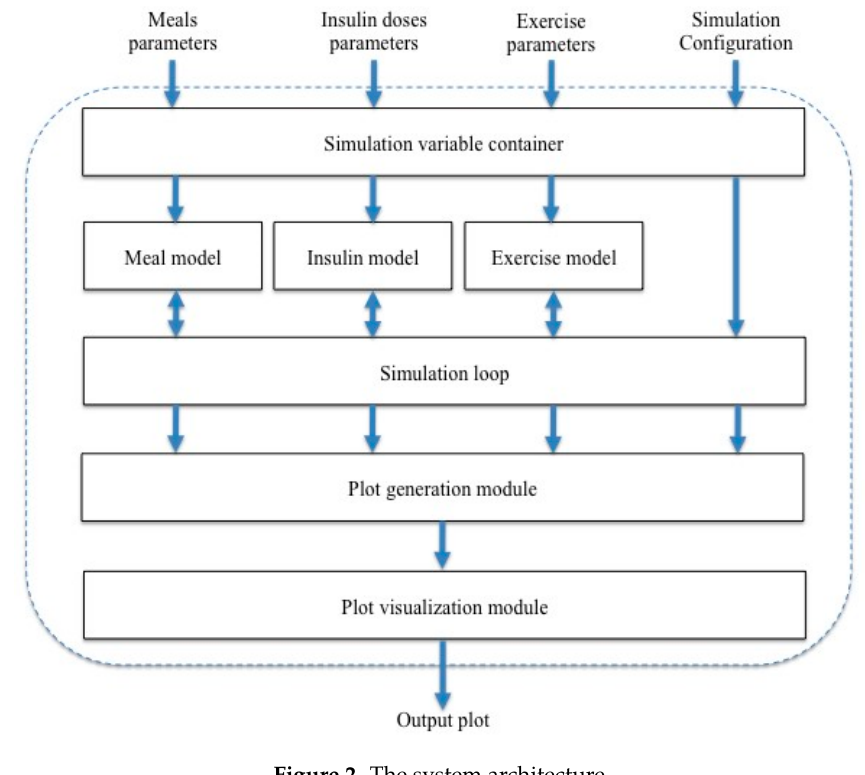
Figure 2. The system architecture.